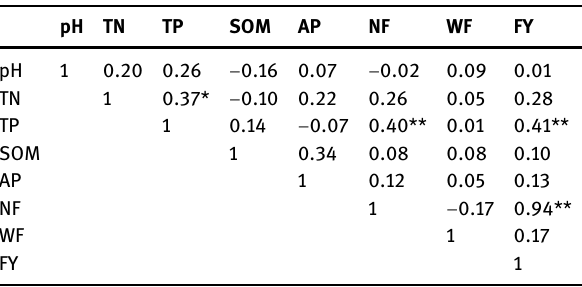
Table 6: Pearson correlation matrix between the soil fertility prop - erties of subsoil layer and fruit yield ( n = 48 )